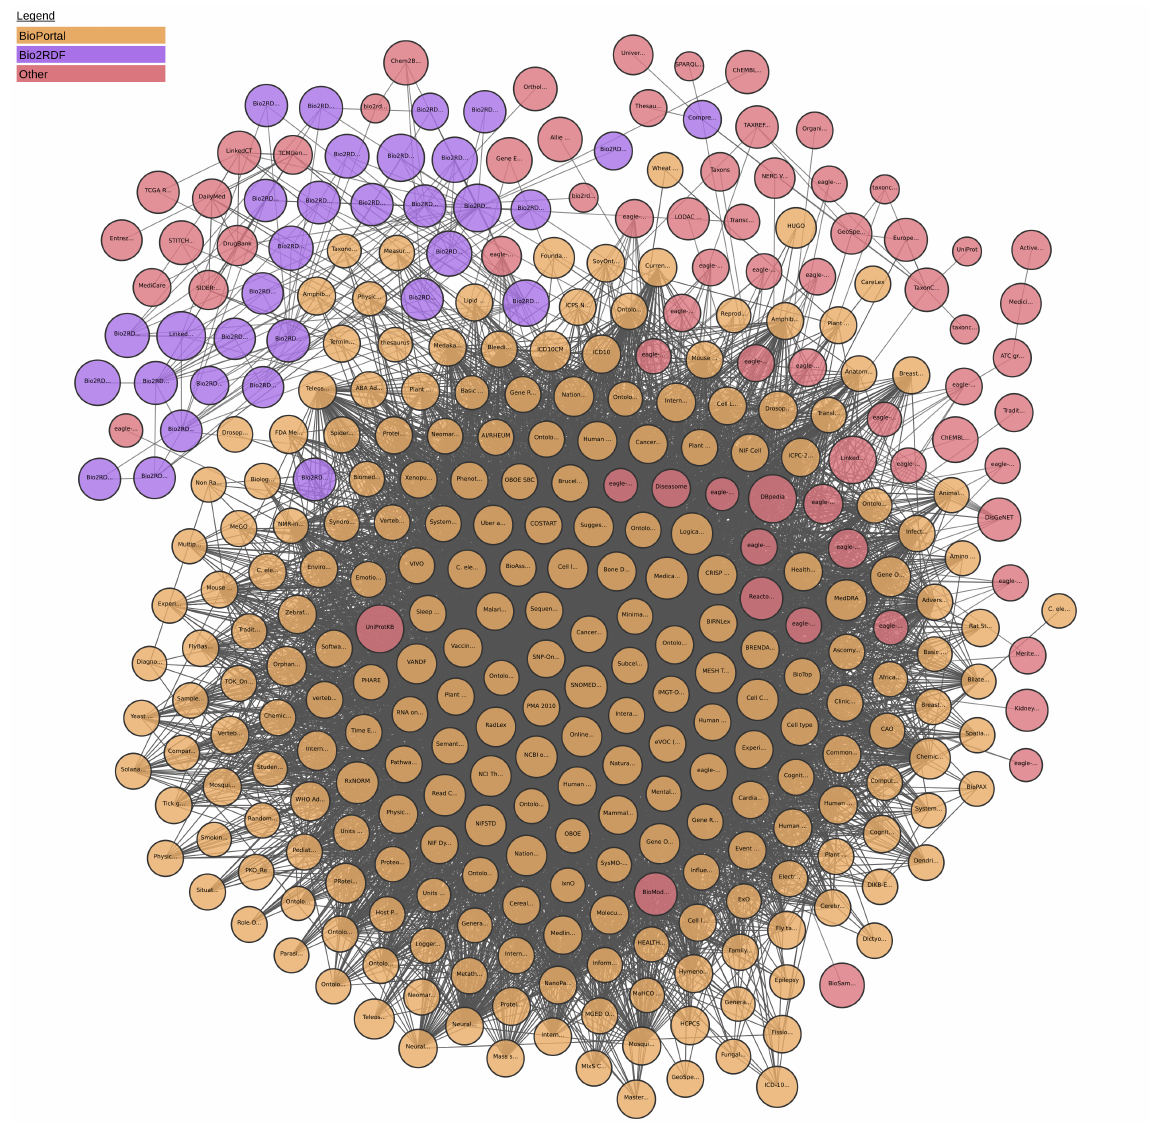
Figure 1. Showing the life science Linked Data